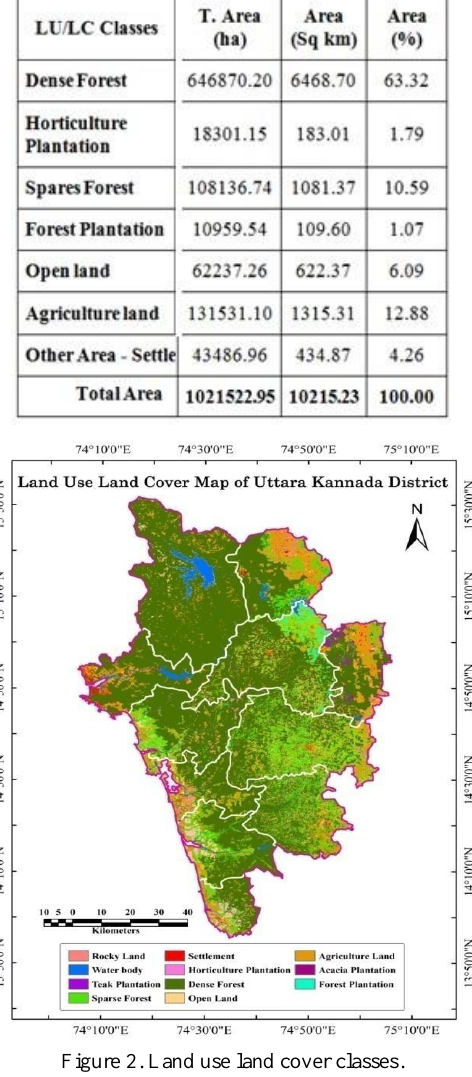
Figure 2. Land use land cover